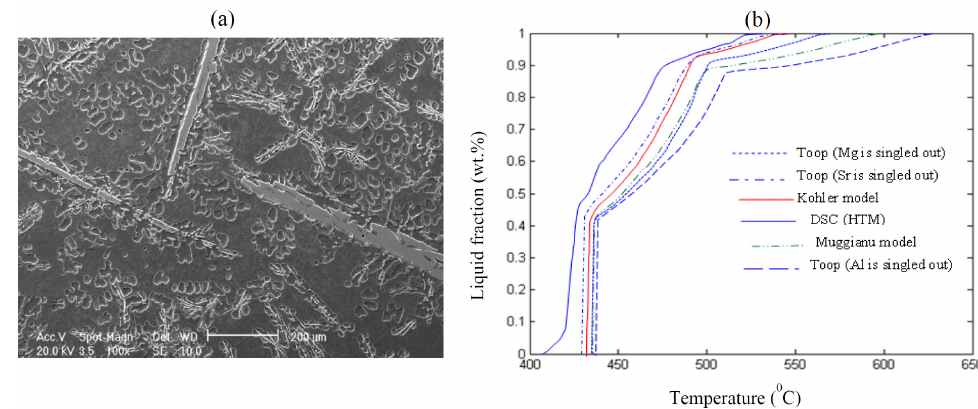
Figure 5. (a) SEM image and (b) Solidification curves of sample 3(6.88/27.67/65.45, Sr/Al/Mg,